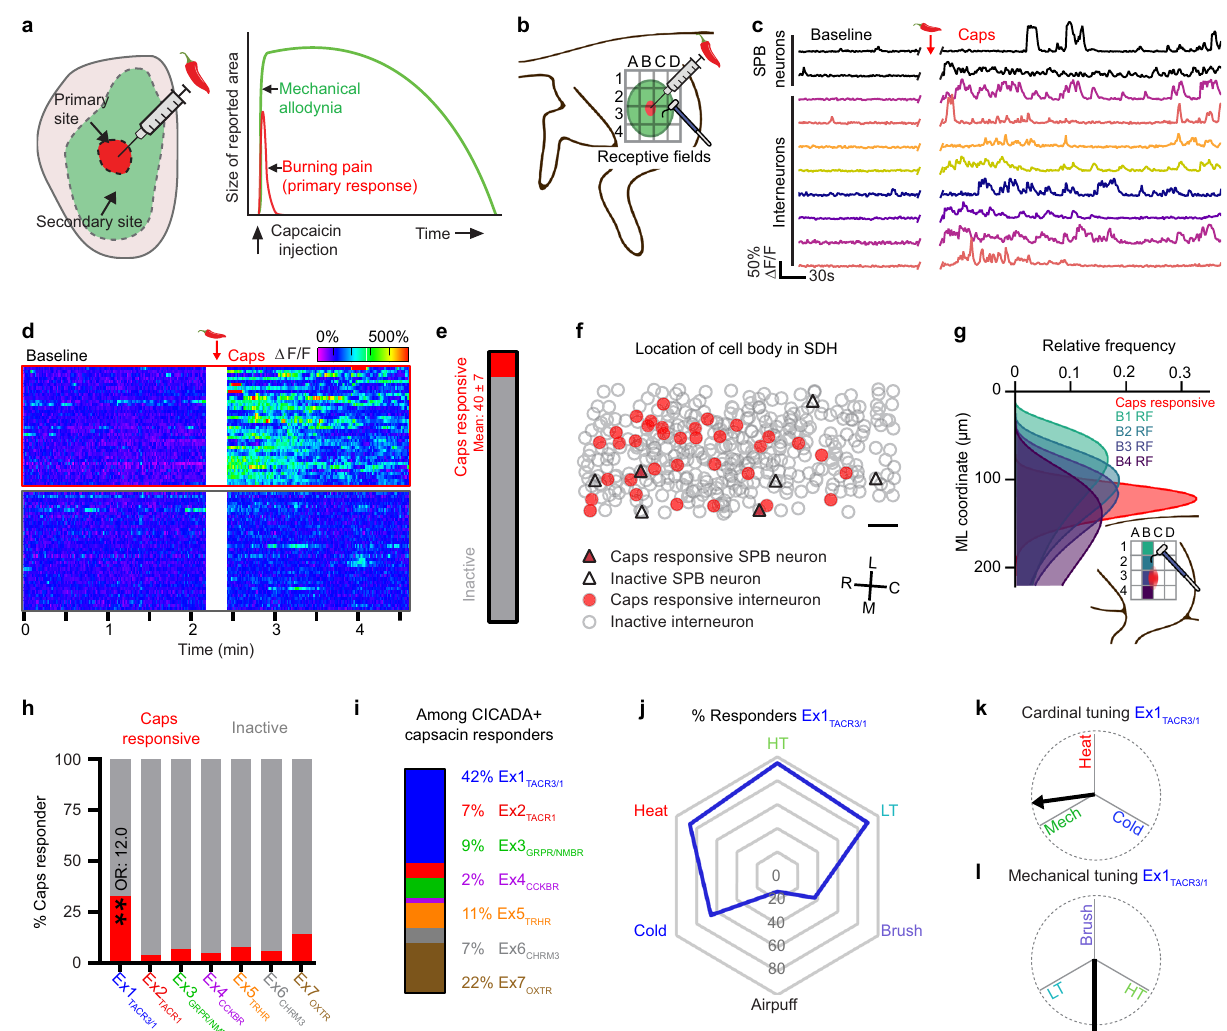
Fig. 5 | Intradermal capsaicin rapidly activates a localized subset of excitatory cells which are enriched within Ex1 TACR3/1 . a Schematic of intradermal capsaicin (caps) model of central sensitization. Relative size and location of the primary and secondary sitesare shown on the left and duration/intensity of the psychophysical phenomena within each region are shown on the right. b Schematic for capsaicin injectionandtestingintheexvivopreparation,thegreygridshowsthetestingsites for receptive fi eld mapping. c Example Δ F/F Ca 2+ traces from cells which were responsive to capsaicin injection. d Heat map of Δ F/F Ca 2+ traces from cells within the same spinal cord which were activated or quiescent after capsaicin injection. e Percent of excitatory cells activated by capsaicin. N =4 mice, mean±SEM. f Somatic location inthe SDH of SPB neurons (triangles) and interneurons (circles) which were either quiescent (open) or active (red) after capsaicin injection (scale bar, 50 µ m). Rostral (R), caudal (C), medial (M), and lateral (L) are indicated on the black cross. g Using the relative distribution of cells along the medio-lateral (ML) axis activated by HT stimulation at different receptive fi elds (RF) we can infer the